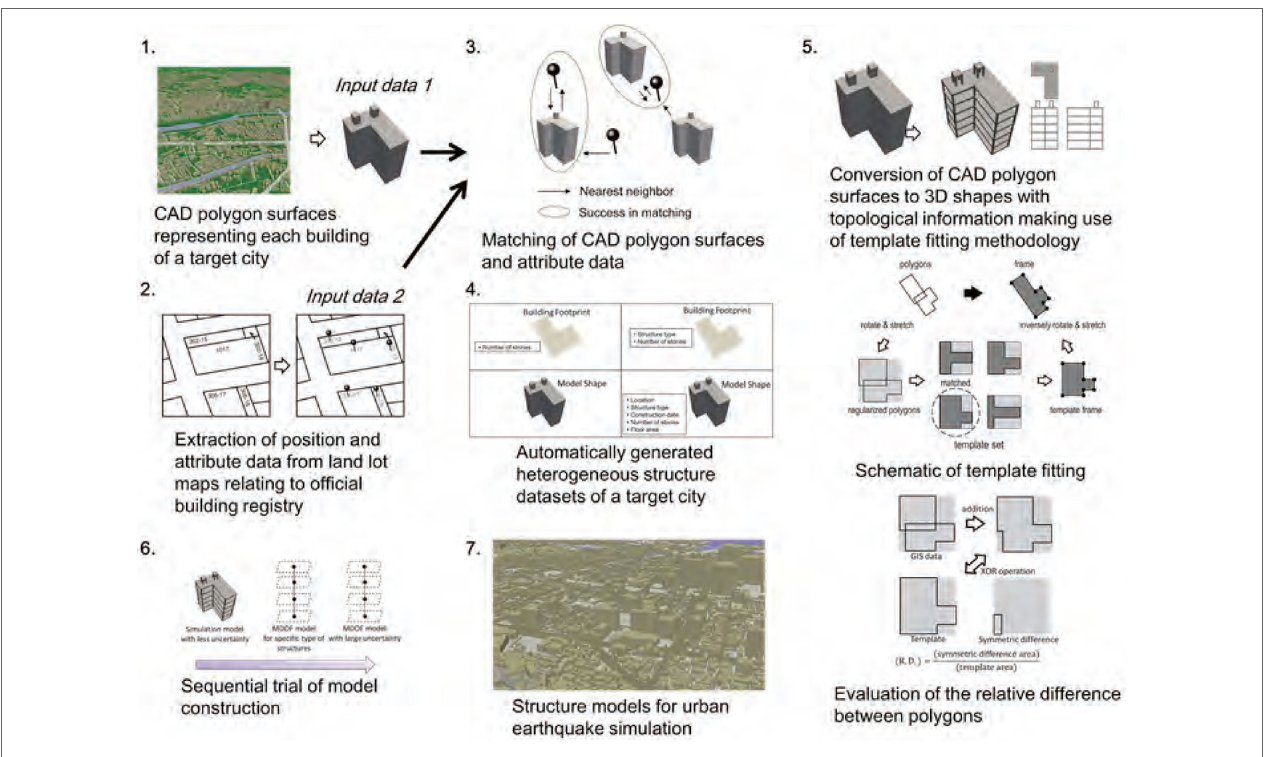
FigUre 4 | Flow of automated model